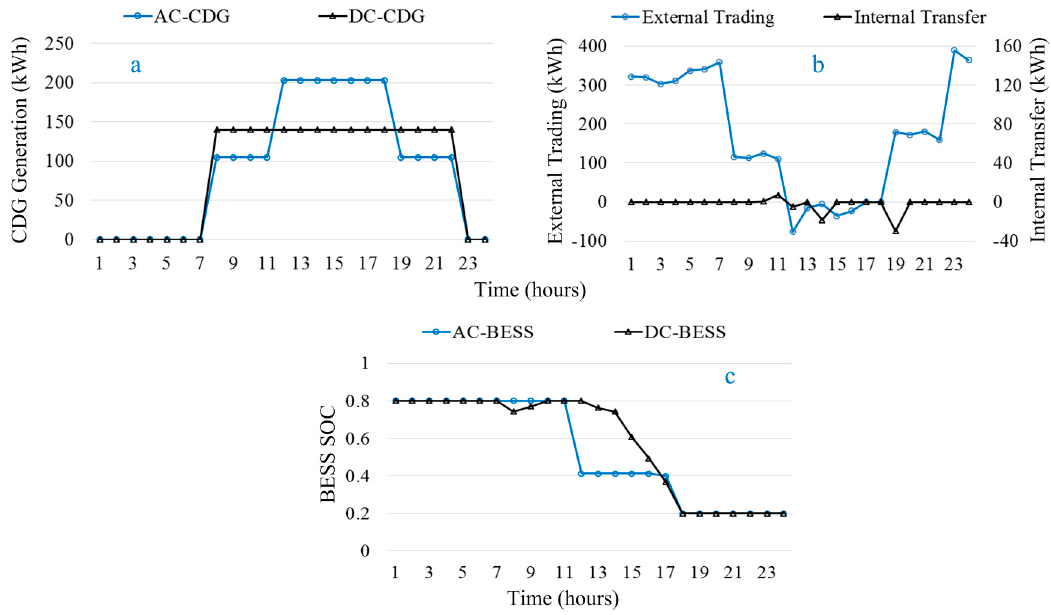
Figure 11. Operation results of conventional case: ( a ) CDG generation; ( b ) power trading; ( c ) BESS SOC.